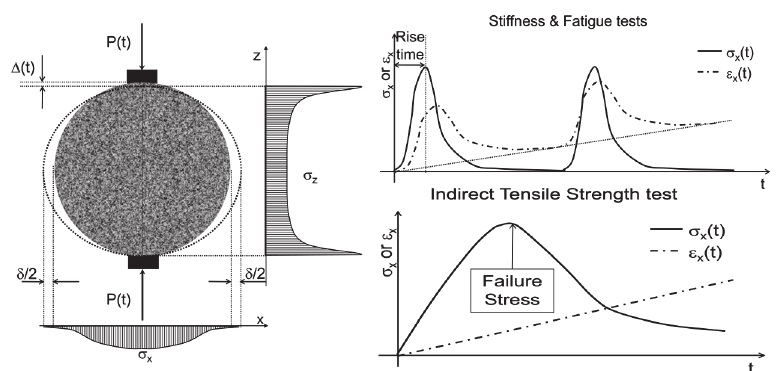
Fig. 6. Scheme of indirect tensile tests for the evaluation of elastic stiffness, indirect tensile strength and fatigue